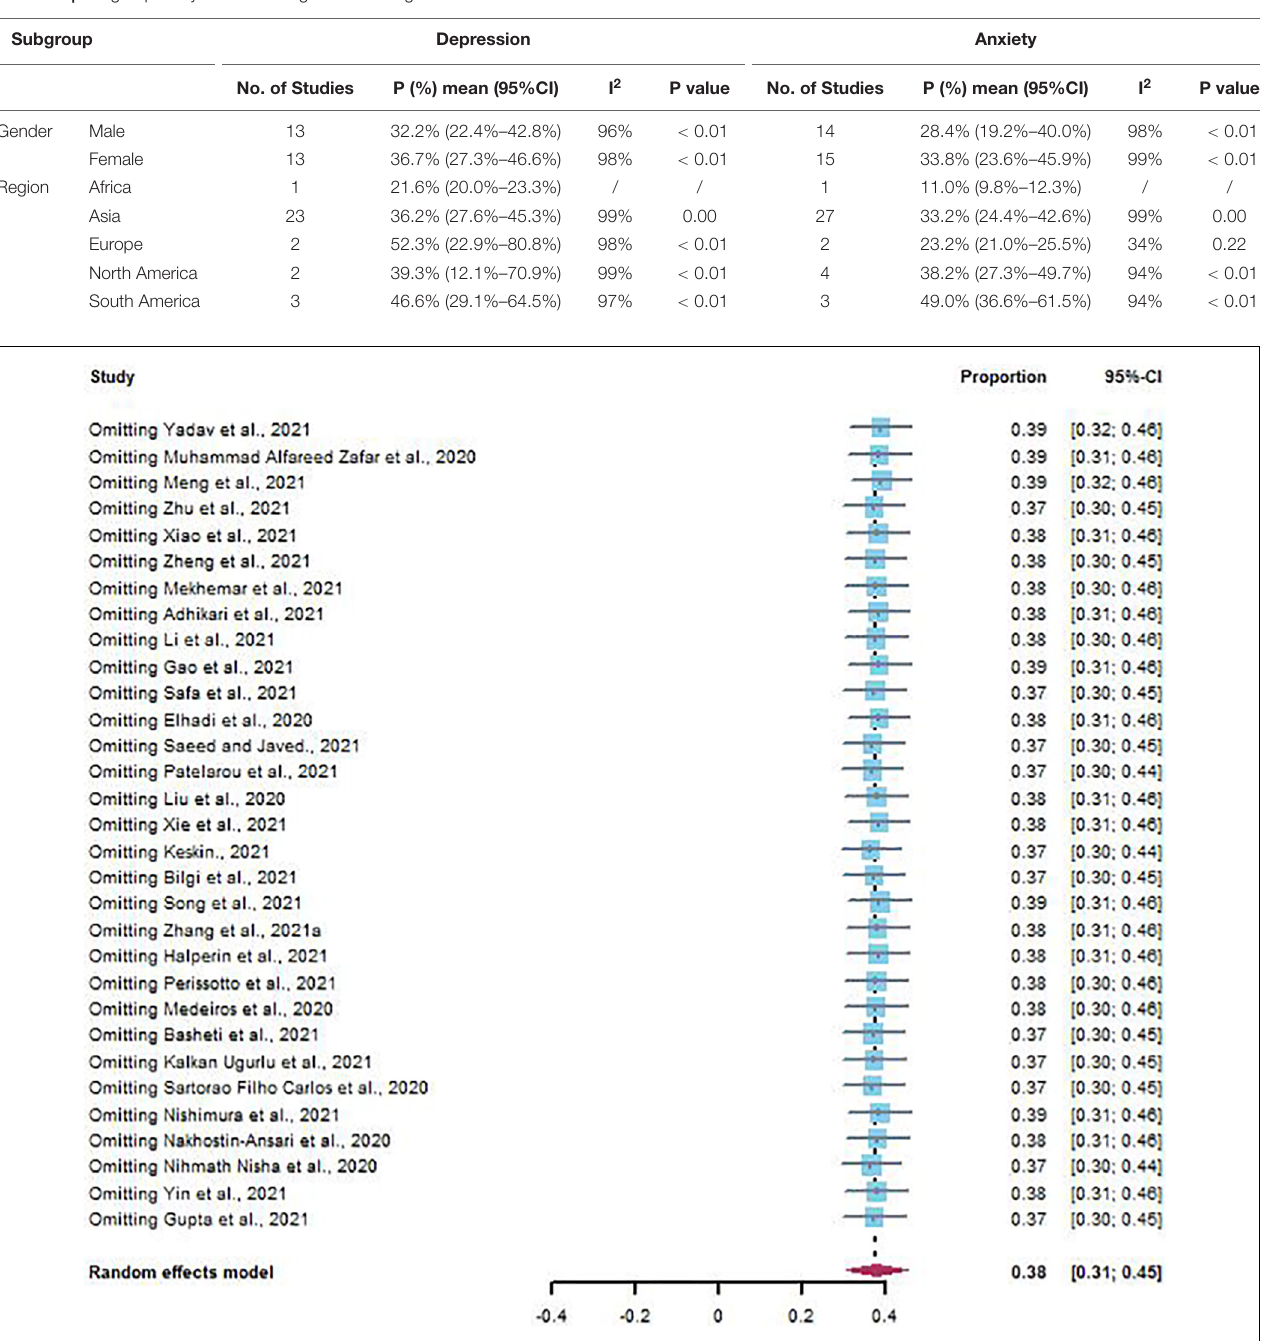
FIGURE 6 | Sensitivity analysis of